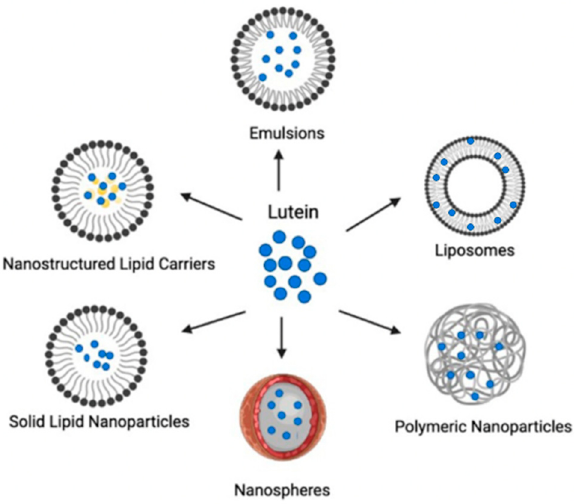
Figure 2. Schematic representation of nanoscale delivery systems for lutein .